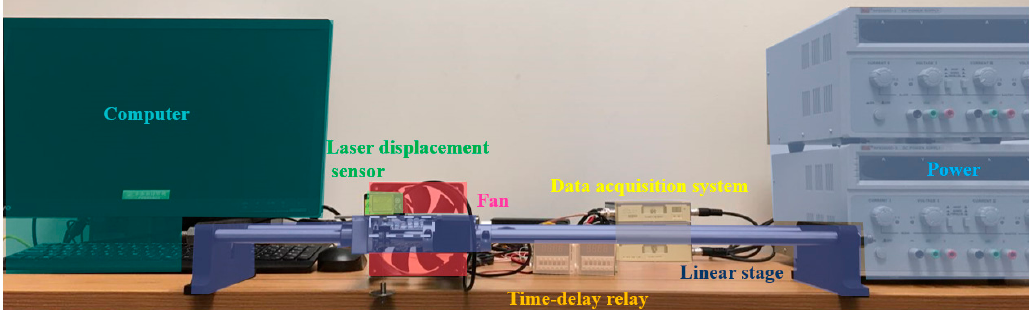
Figure 7. Thermomechanical test setup.